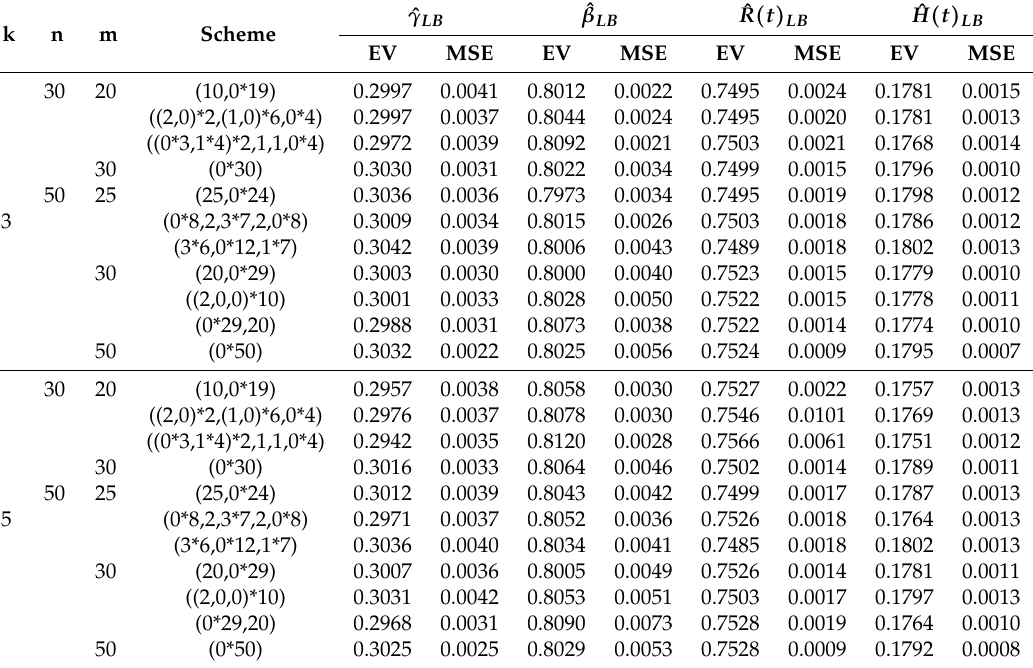
Table 9. Lindley approximation values and MSEs of parameters and reliability and hazard functions under GELF when q = 0.5, γ = 0.3, β = 0.8, t = 1.5, a 1 = 1.08, b 1 = 3.6, a 2 = 16, b 2 =